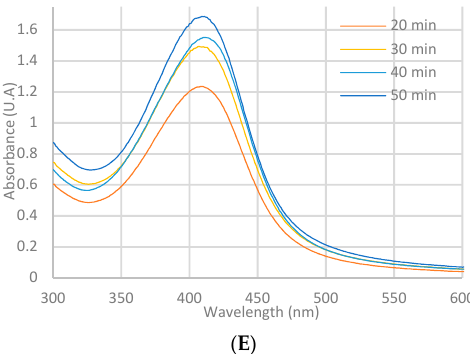
Figure 2. Ultraviolet–visible (UV–Vis) spectra of synthesis parameters of M. Albida silver nanoparticles ( Ma AgNPs) concentration of silver nitrate ( A ), volume of extract ( B ), pH ( C ), temperature ( D ) and contact time ( E ).